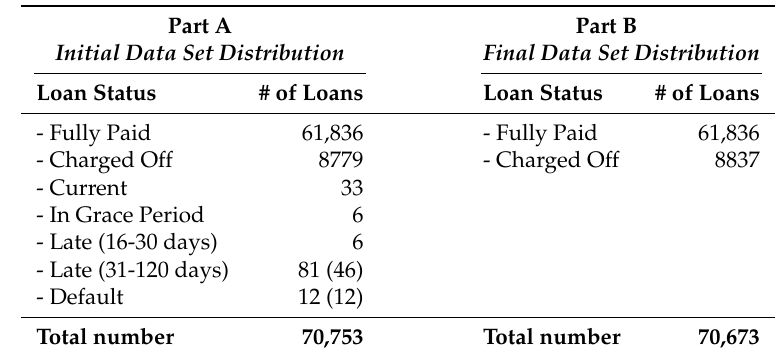
Table 2. Distribution of Loan